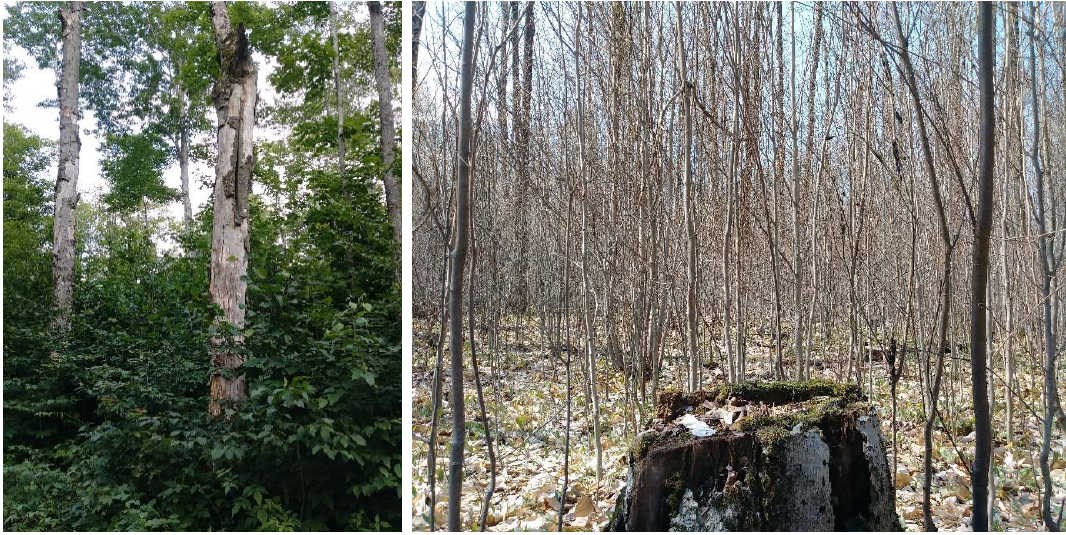
Figure 7. Beech ‐ dominated small sapling recruit layers on study sites. Figure 7. Beech-dominated small sapling recruit layers on study